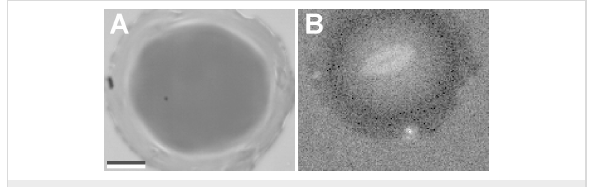
Figure 3: Sample 1 in dry contact with glass (A) and in contact with glass underwater (B). Scale bar, 10 µm.